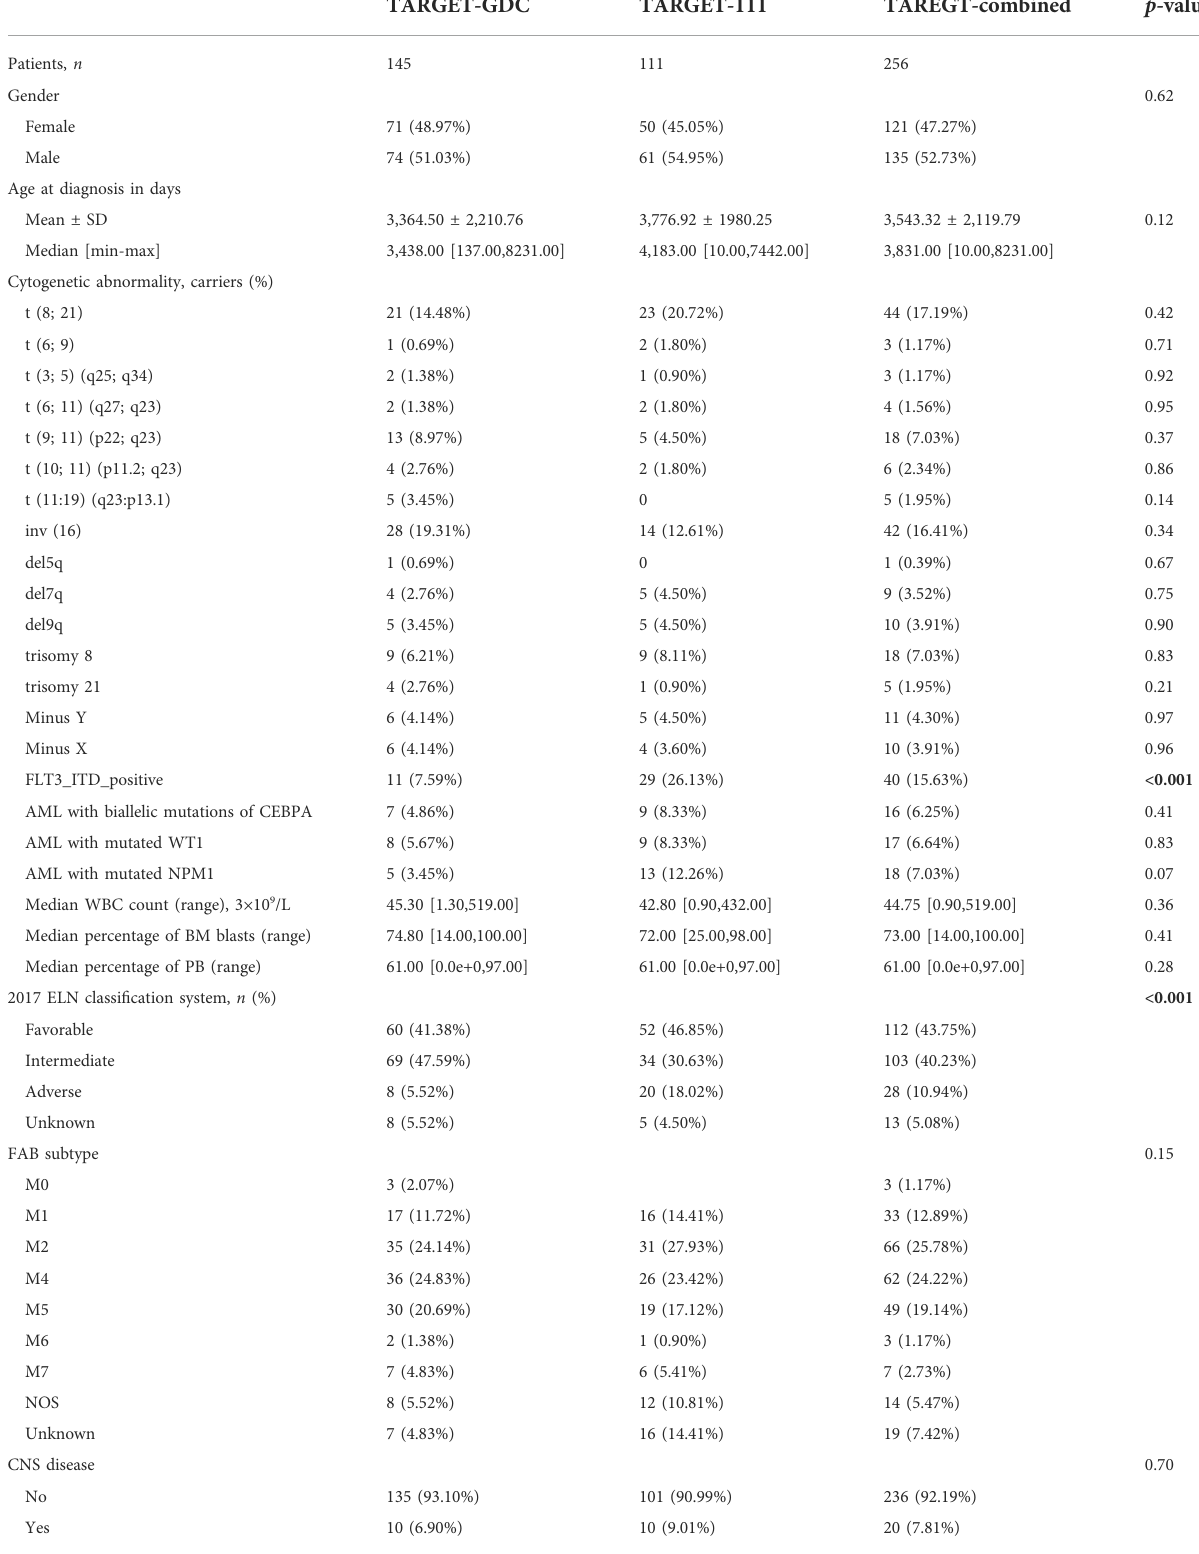
TABLE 1 Summary of P-AML patient clinical information from TARGET-Discovery and validation